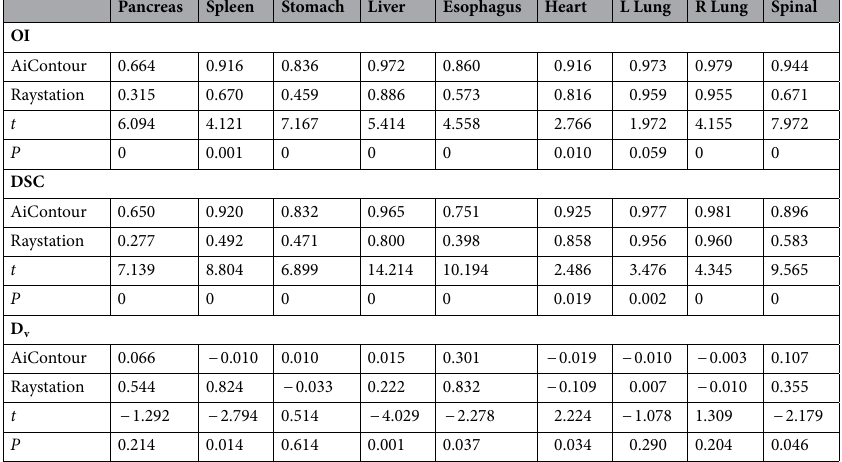
Table 2. Comparison of OI and DSC for OAR automatic delineation of lung cancer by two software.